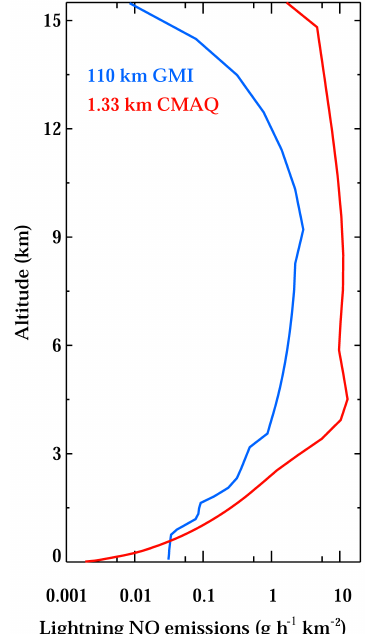
Figure 3. Mean June and July 2011 lightning NO emissions as a function of altitude from the GMI (1 . 25 ◦ × 1 ◦ ; ∼ 110km × 110km) and CMAQ (1 . 33km × 1 . 33km) model